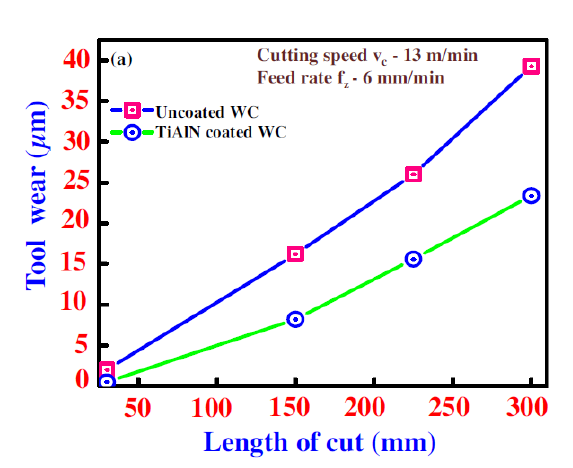
Figure 8: Progress of tool wear with machining length for TiAlN coated and uncoated WC micro-end mills [46] strain gauge to measure cutting forces is another method reported in machining literature [53].